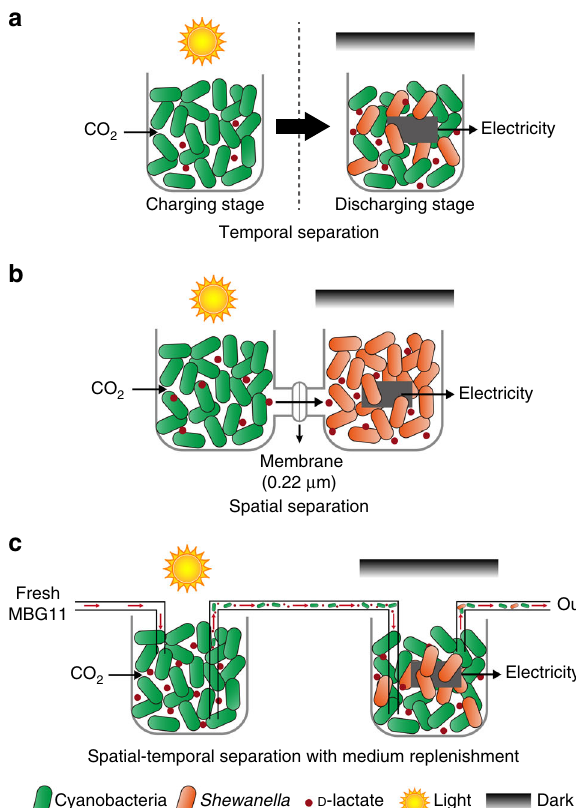
Fig. 2 Schematic illustration of three setups used for constructing microbial consortium. a Temporal separation setup. The charging process (photosynthetic production of D -lactate) and discharging process are implemented sequentially under light and dark conditions,